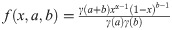
Estimated PDFs of slopes and hiking approximations in the Aztec region.The raster resolution is 222 m. Compared with other continuous distributions, in the slope approach, there are two PDFs that best describe the data: power law and exponential. The former uses a probability density function of the form f(x, α) = αxα−1, for 0 <= x <= 1, α > 0. The latter shows a probability density function of the form f(x) = exp(−x), for x >= 0. In addition, the hiking approach—velocity of walking—shows two PDFs that best describe the data: beta and exponential. The beta distribution uses a probability density function of the form f(x,a,b)=γ(a+b)xα−1(1−x)b−1γ(a)γ(b), for 0 < x < 1, a > 0, b > 0. The exponential distribution shows the same probability density function as the slope data. Table 1 shows the estimated parameters, KS test statistics, and first moments of these PDFs. For supporting information, OSFNotebook and S1 Table.